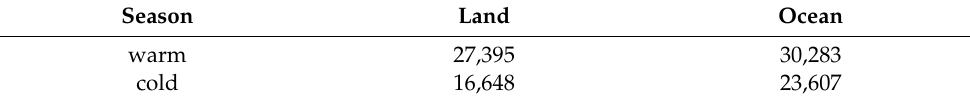
Table 2. Data set for neural networks acquired under clear sky conditions in the Arctic.